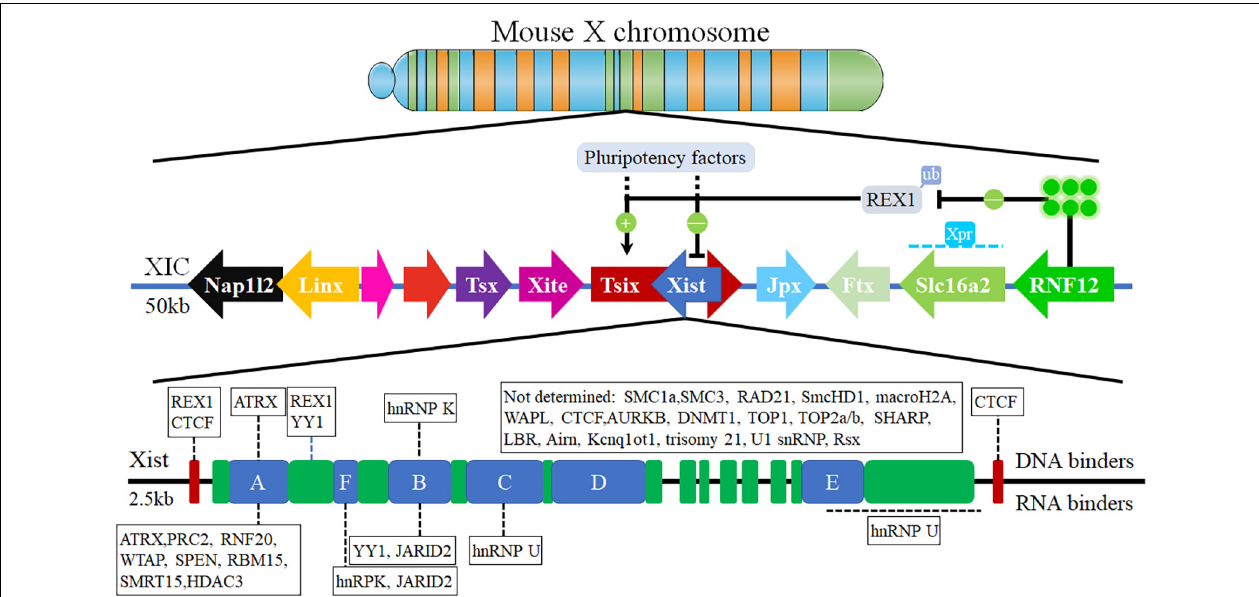
FIGURE 1 | The X-chromosome Inactivation Center (Maduro et al., 2016). The X inactivation center consists of the different genes located and multiple genes encoding lncRNA, containing Xist, Tsix, Tsx, Xite, Jpx, Ftx, DNA binders, and RNA